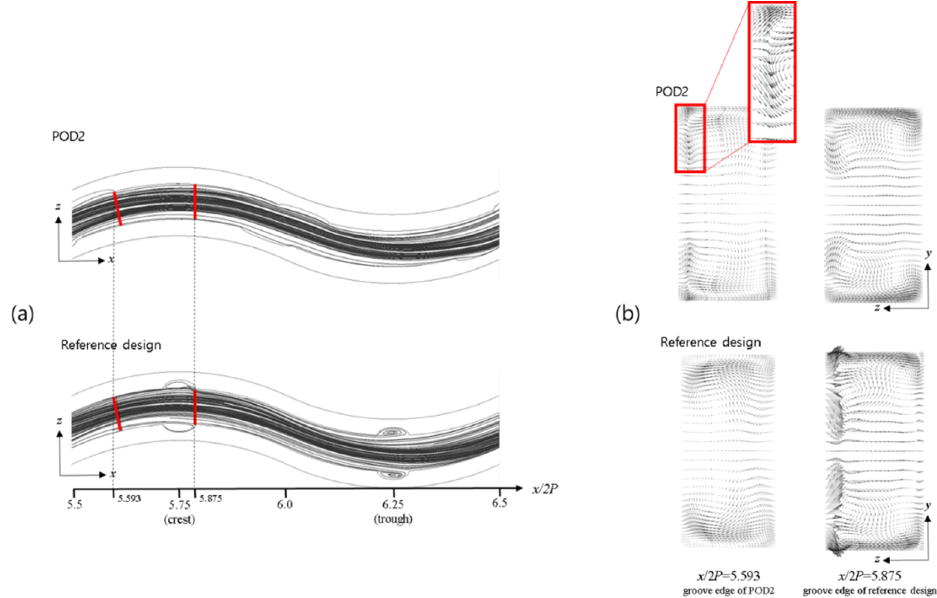
Figure 17. Streamlines and velocity vectors: ( a ) streamline distributions on the x – z plane ( y / H = 0.6) ( b ) velocity vector in cross-section perpendicular to flow